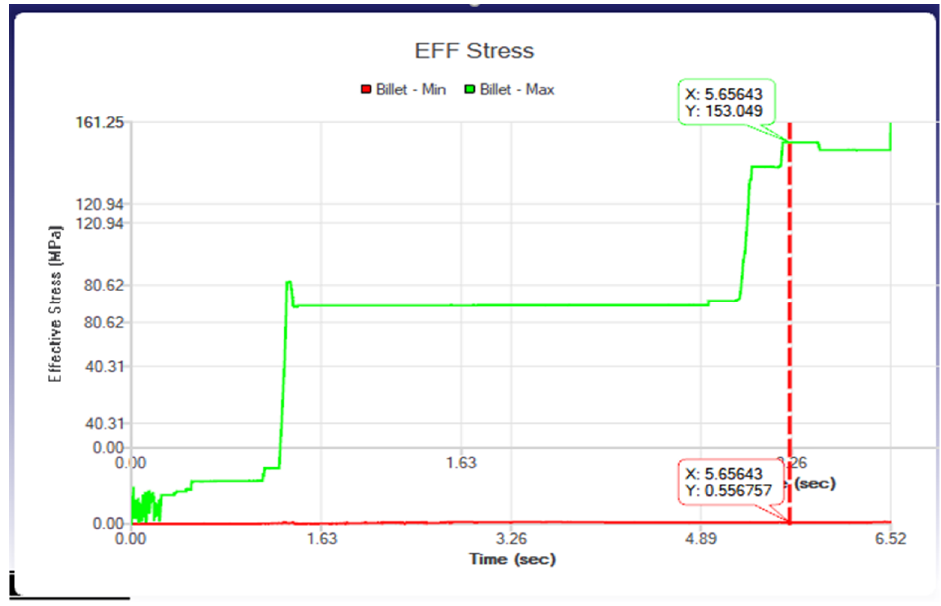
Figure 7. The effective stress for three subsequent swaging passes. Figure 7. The e ff ective stress for three subsequent swaging